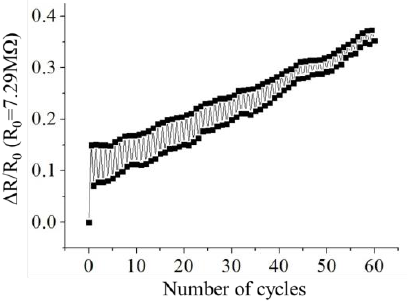
Figure 12. Durability of strain gauge. A 5-grid strain gauge was used. The max strain of stretching was 10% and strain of releasing was 0%.